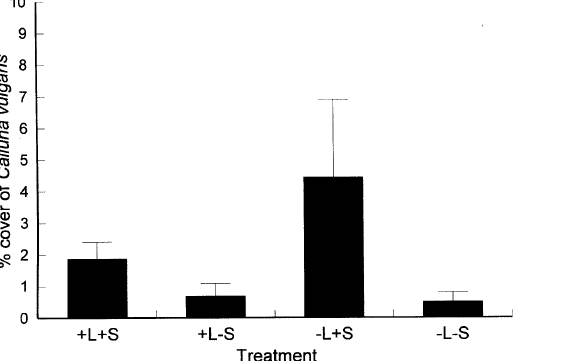
Fig. 3. The effects of litter disturbance (–L) and Calluna vulgaris seed addition (+S) on the mean cover ( ± 1 SE, n = 16) of C. vul- garis five years after treatment at Hordron Edge.